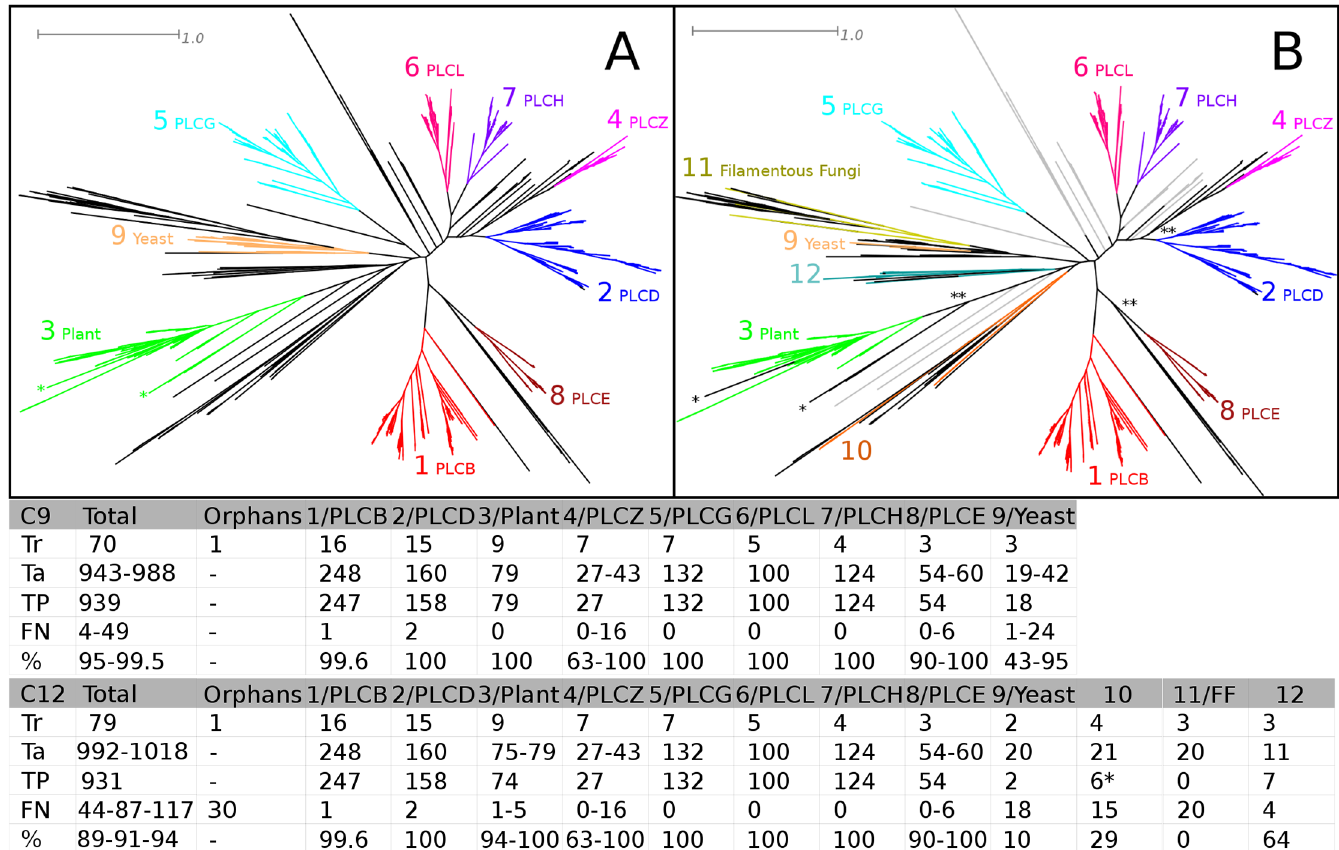
Fig 4. HMMERCTTER analysis of the phospholipase C superfamily. (A) Initial C9 classification of nine described PLC subfamilies. (B) C12 Classification upon inclusion of additional sequences to the training set. Colors according to HMMERCTTER output of C9 clustering, leaves in black or gray could not be classified. Black leaves were included in determination of classification recall or classification recall interval, (cid:3)(cid:3) in B indicates classes where the reference classification is ambiguous. The 30 unclassifiable sequences are represented in gray. The (cid:3) in A and B point to differences in the classification of Plant PLCs. The table shows the numerical results of the C9 and C12 classifications. Tr = Train; Ta = Target; TP = True Positives; FN = False Negatives; % = Classification recall (TP/(TP + FN)). (cid:3) Includes the training orphan. Classification recall intervals are presented when the reference classification is ambiguous and are accompanied by intervals in the number of target sequences and false negatives. The 30 unclassifiable sequences indicated in gray in B were regarded as additional false negatives resulting in the lowest classification recall of the overall classification recall